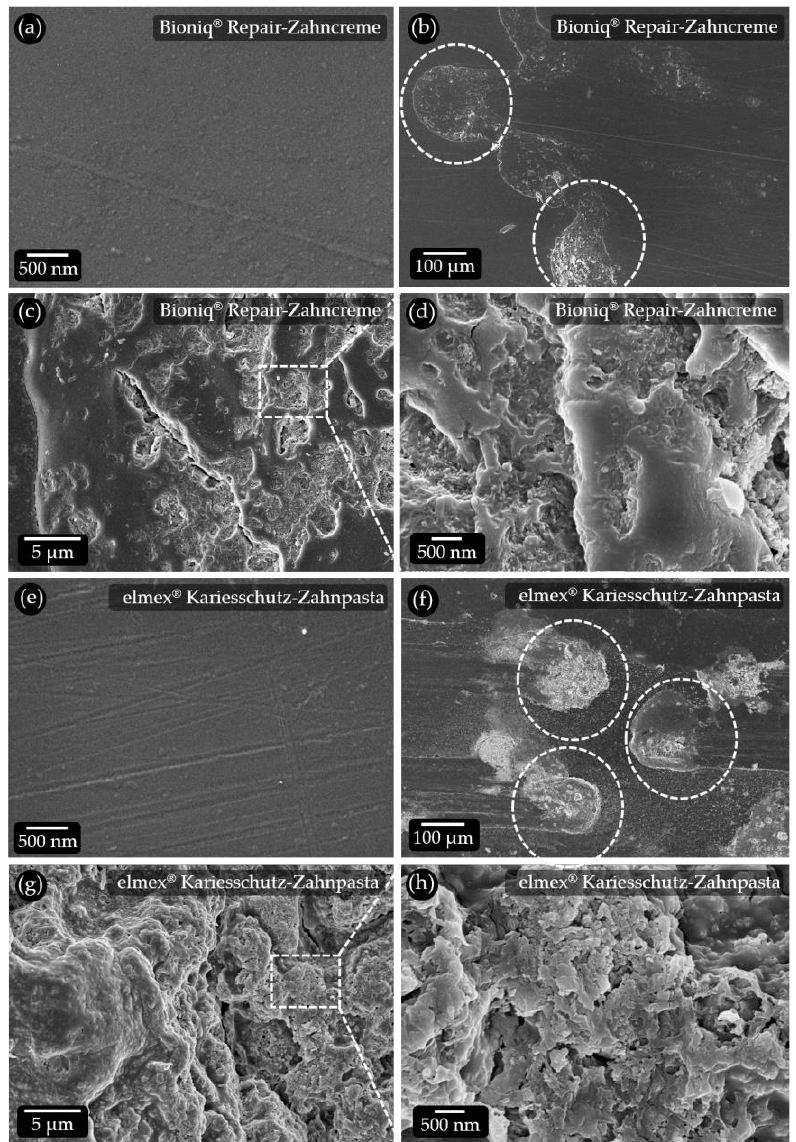
Figure 6. SEM micrographs of the PMMA samples brushed with ( a – d ) Bioniq ® Repair-Zahncreme and ( e – h ) elmex ® Kariesschutz-Zahnpasta. Both products show the formation of pile-ups consisting of polymer material and abrasive particles in different degrees of